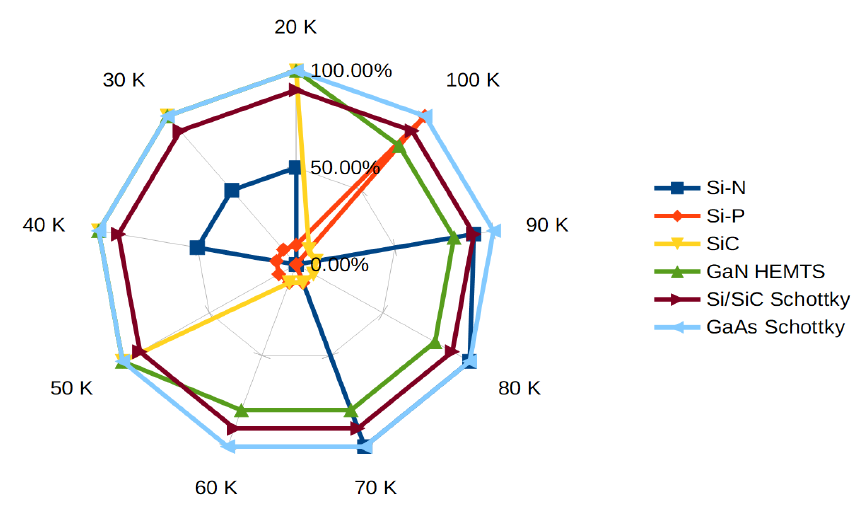
Figure 6. Behavior of the semiconductor switch at cryogenic temperatures (Data adapted from [50]).